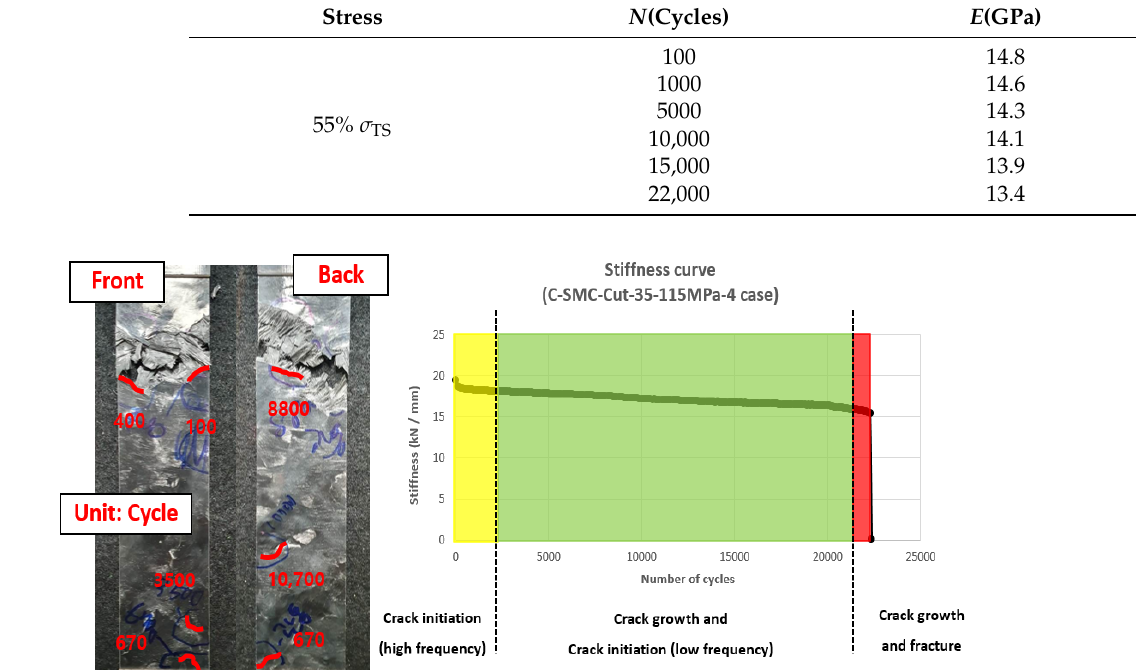
Figure 17. Stress–strain curve change of the elastic modulus. Table 4. Changes in elastic modulus as a function of the number of cycles.